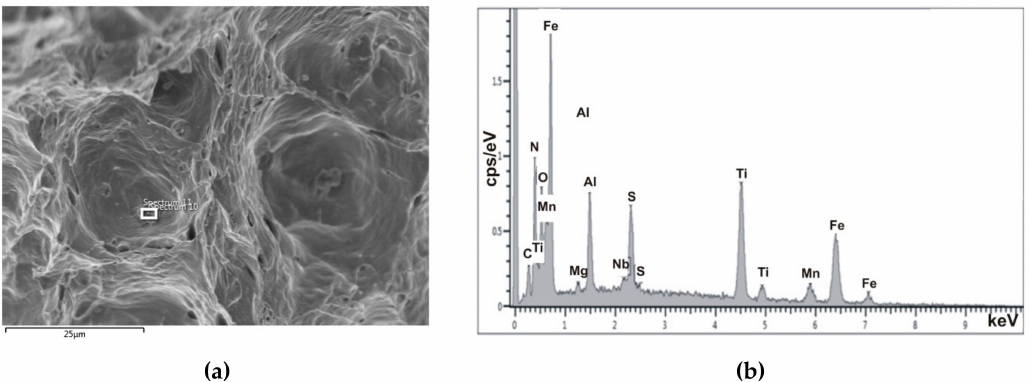
Figure 9. ( a ) Fracture of sample Y4, CT1150-2 ◦ , N f = 95.4, T d = 1050 ◦ C; ( b ) EDX spectrum from the particle in Figure 8a-Fe, Ti, Mn, N, O, S, C, Al, Nb, Mg.